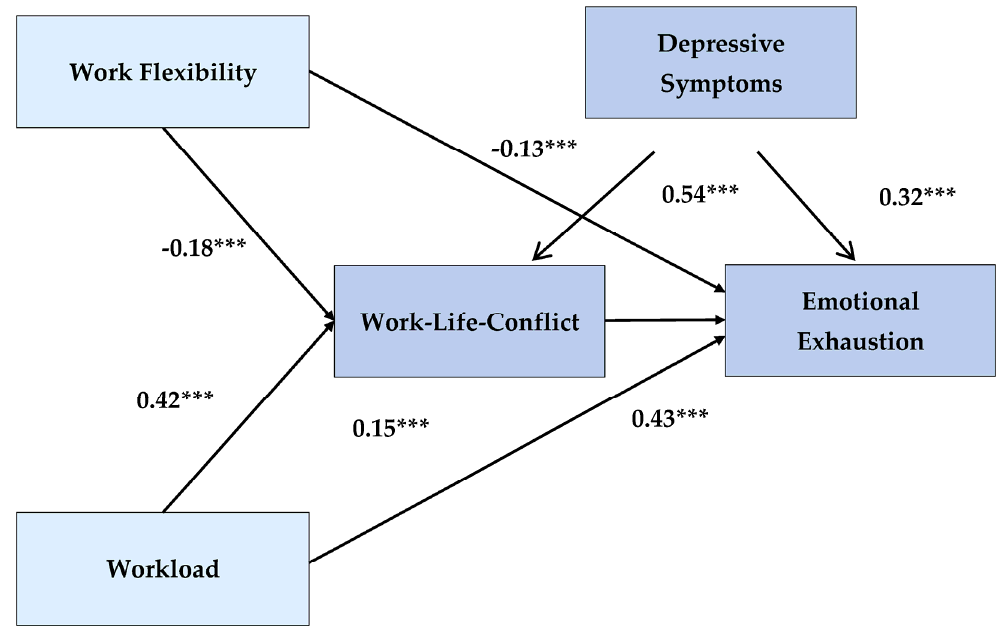
Figure 3. Path model with standardized coefficients, covariances, and their respective significance levels (*** p ≤ 0.001) and with the resolved variances of the endogenous variables (R²) .